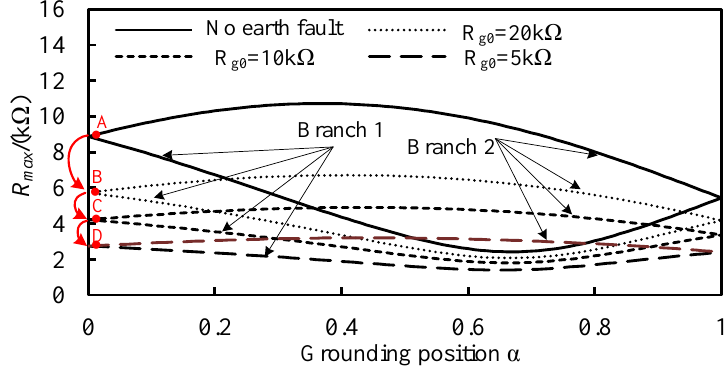
Figure 3. Sensitivity curves of the protection when the stator already grounded by fault resistor R g 0 under the ground transformer grounding mode.